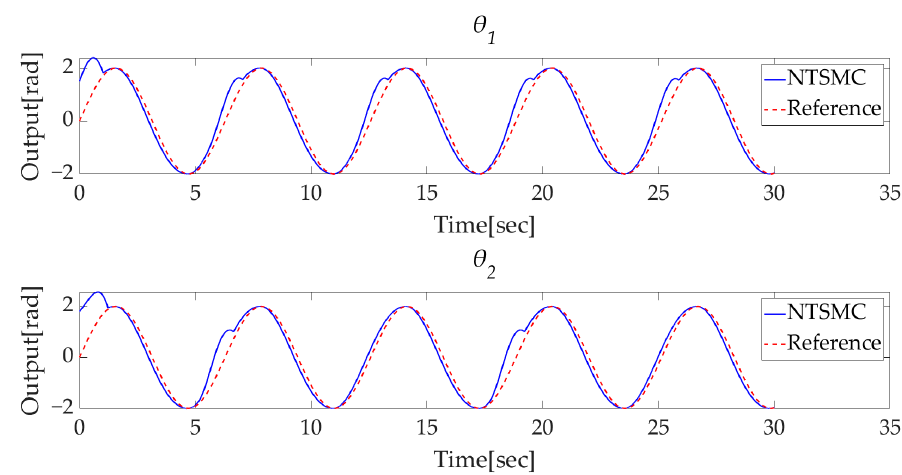
Figure 8. NTSMC control performance for continuous input.